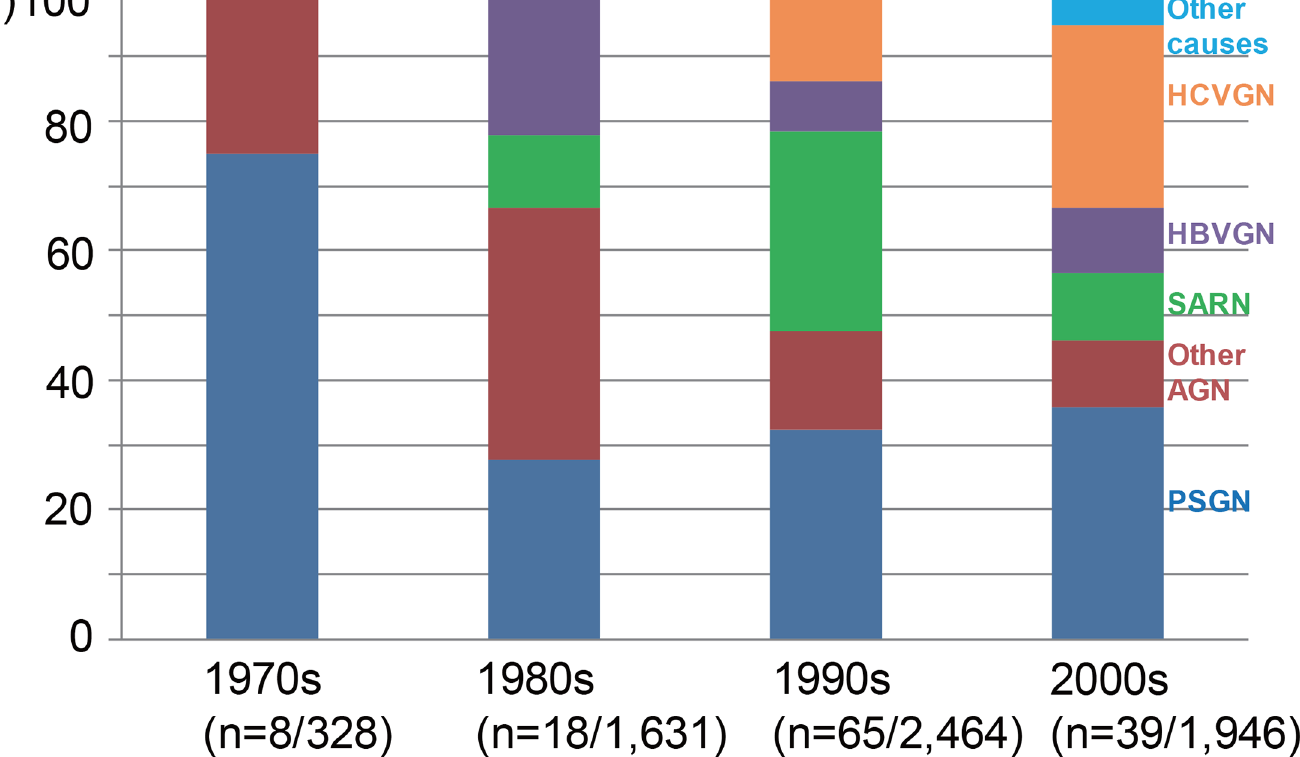
Fig 2. The temporal changes in the detailed contents in PIGN over the four-decade observation period. Abbreviations are explained in the Fig 1